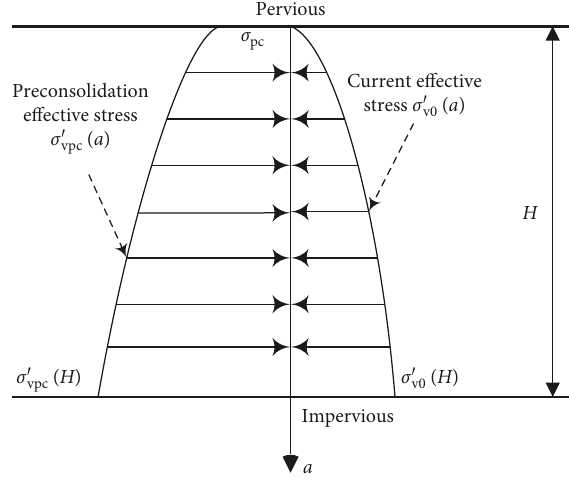
Figure 1: An overconsolidated clay